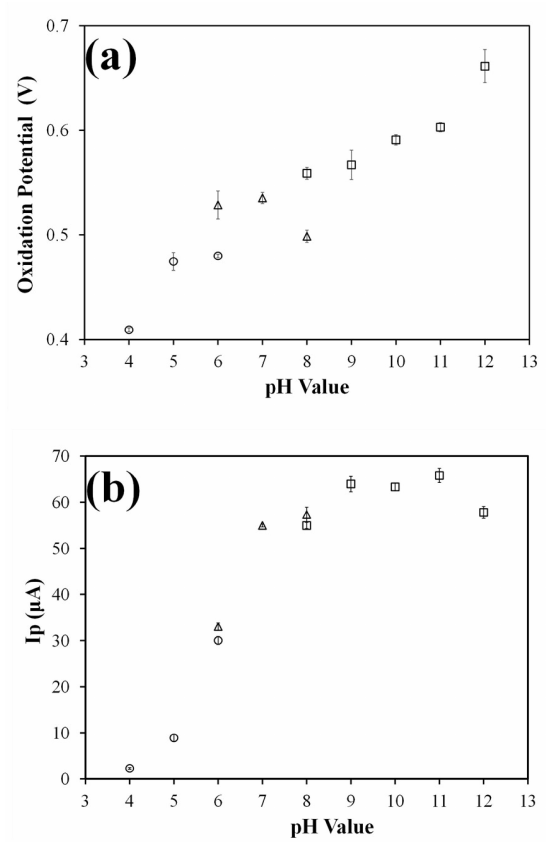
Figure 3. The effect of acidity on the oxidation potential and current of OPA-glycine-NAC isoindole. Cyclic voltammograms were obtained by bare SPCEs with a scan range of 0 ± 0.7 V and a scan rate of 100 mV/s. The solutions used for the experiment contained 5 mM glycine, 5 mM NAC, and 0.1% OPA in 0.1 M citrate buffer (pH 4–6) ( ), 0.1 M PBS buffer (pH 6–8) ( (cid:52) ), and 0.1 M borate buffer (pH (cid:35) 8–12) ( (cid:3) ). The oxidation potentials and currents (I p ) are the anodic peak potential and the anodic peak current, respectively, obtained from the same cyclic voltammogram. A typical CV is the same